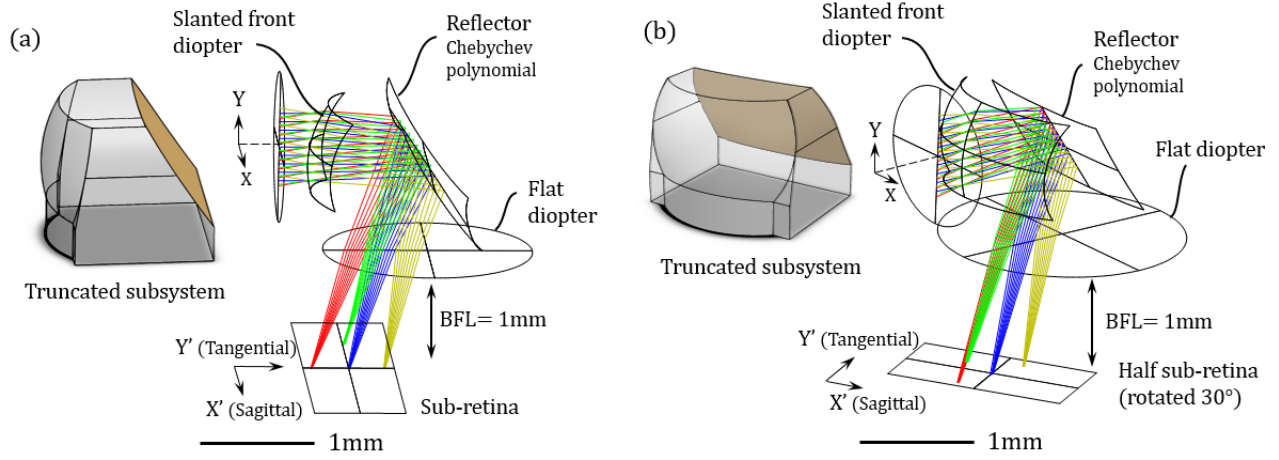
Figure 6. ( a ) Design of the S subsystem alongside its truncated model. ( b ) Design of the FS/BS subsystem alongside its truncated model.